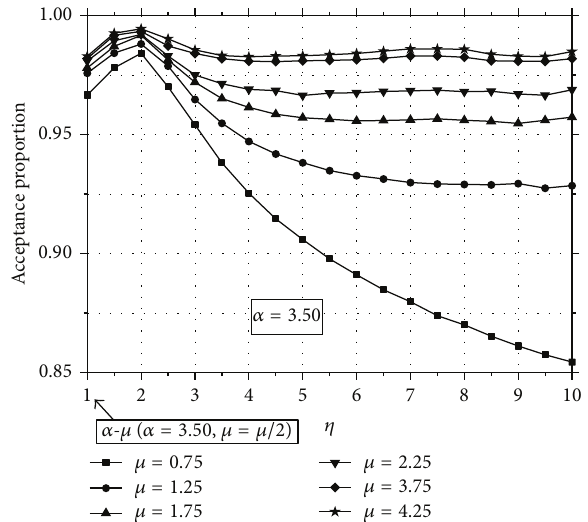
Figure 5: Rejection method efficiency for the 𝛼 - 𝜂 - 𝜇 distribution with 𝛼 = 3.5 .